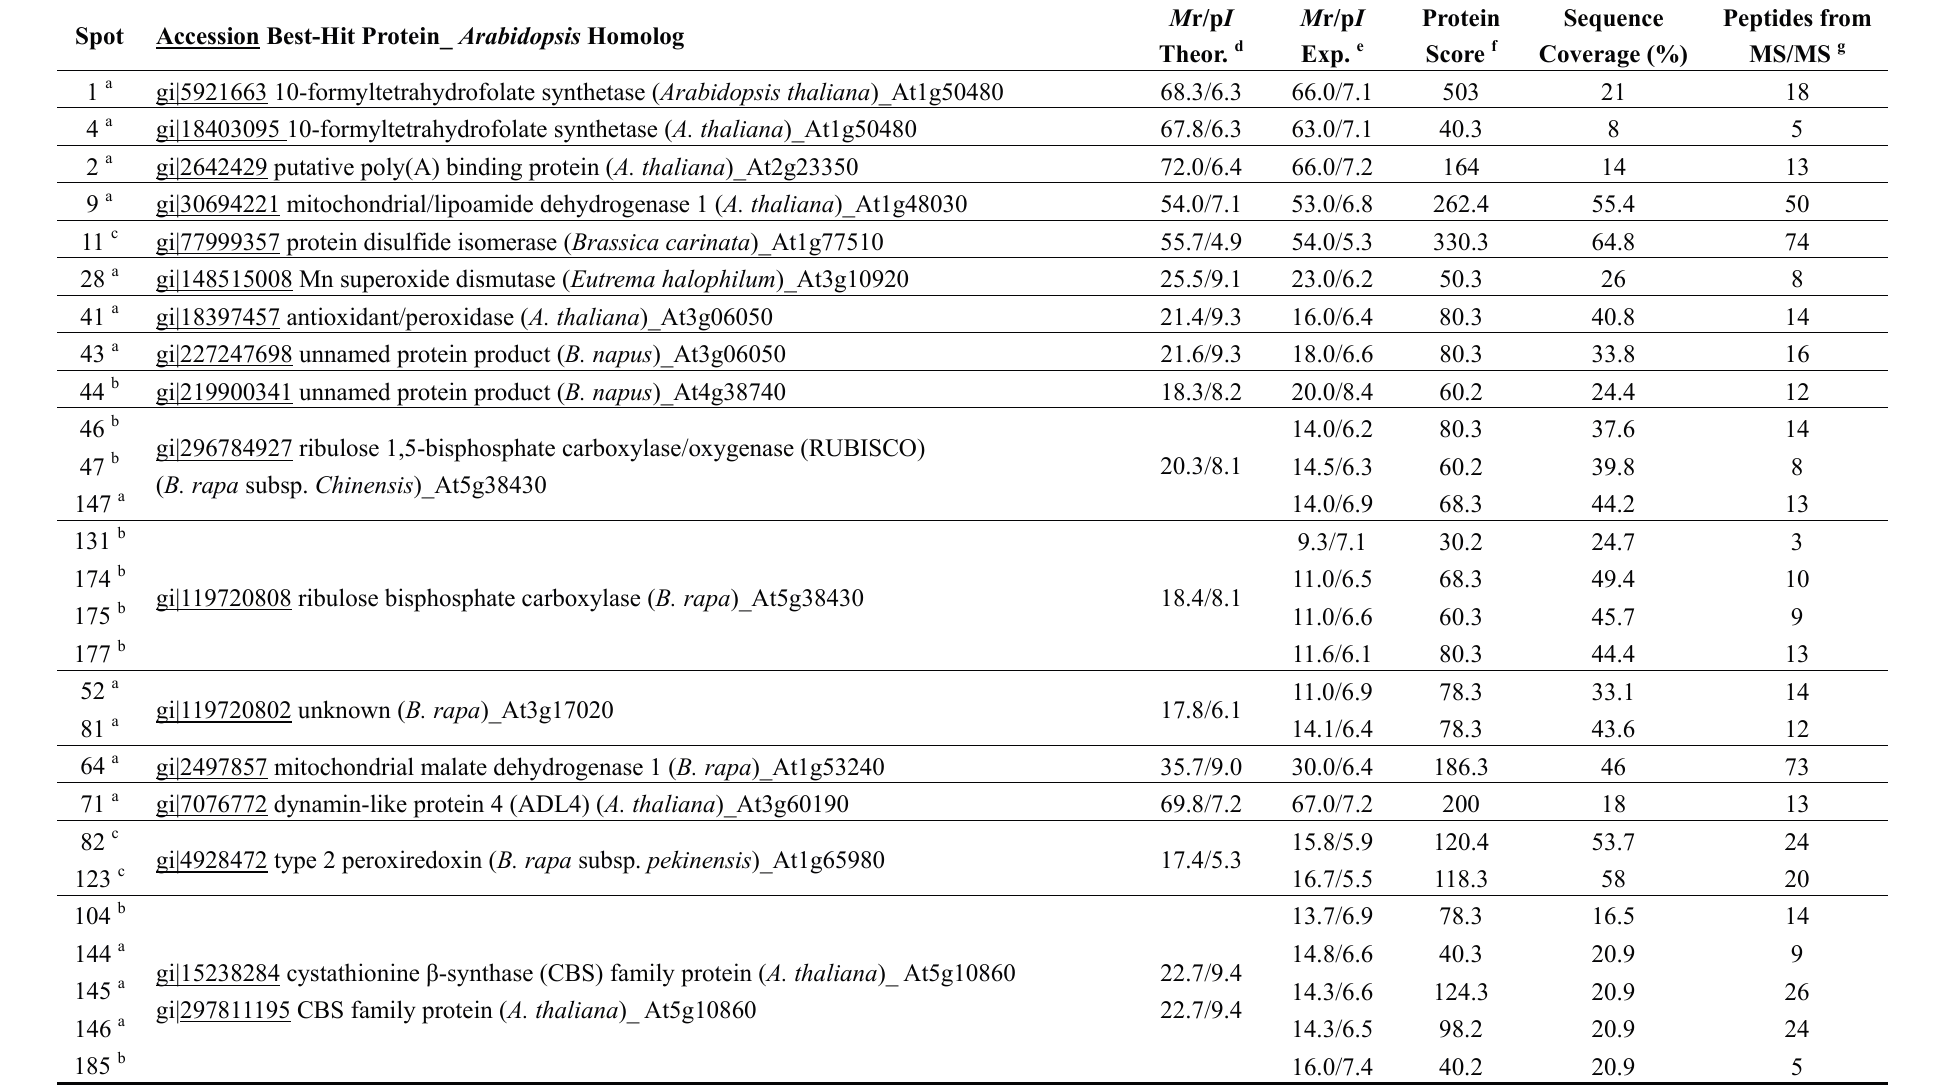
Table 4. Proteins specifically identified in isopentenyltransferase (ipt) -transgenic